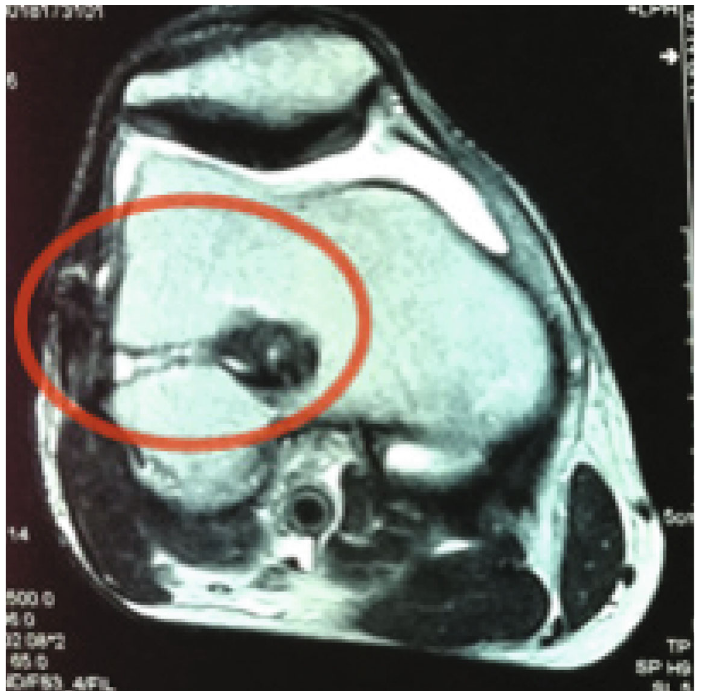
Figure 2: Magnetic resonance image (MRI) showing the fi stula, marked with a red circle, that connects the ACL graft femoral tunnel to the cortical bone. The tunnel is fi lled with synovial fl uid which comes from inside the joint. This image also shows the soft tissue disruption in the lateral aspect of the femoral condyle.